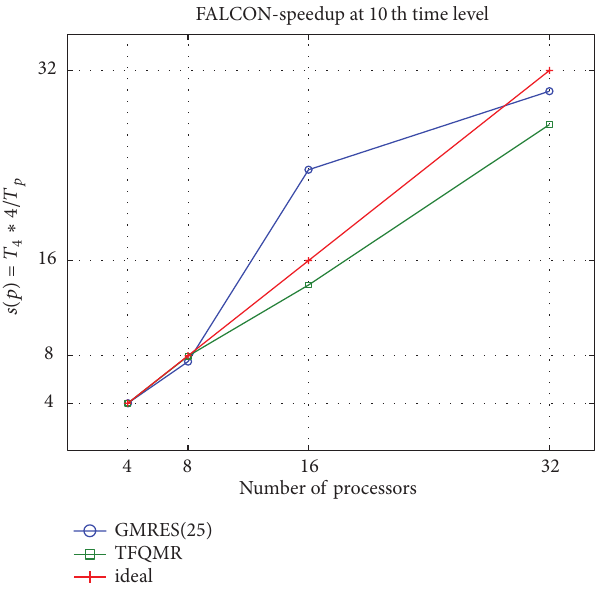
F 5: FALCON aircra. Relative speedup curves taken at the 10th time